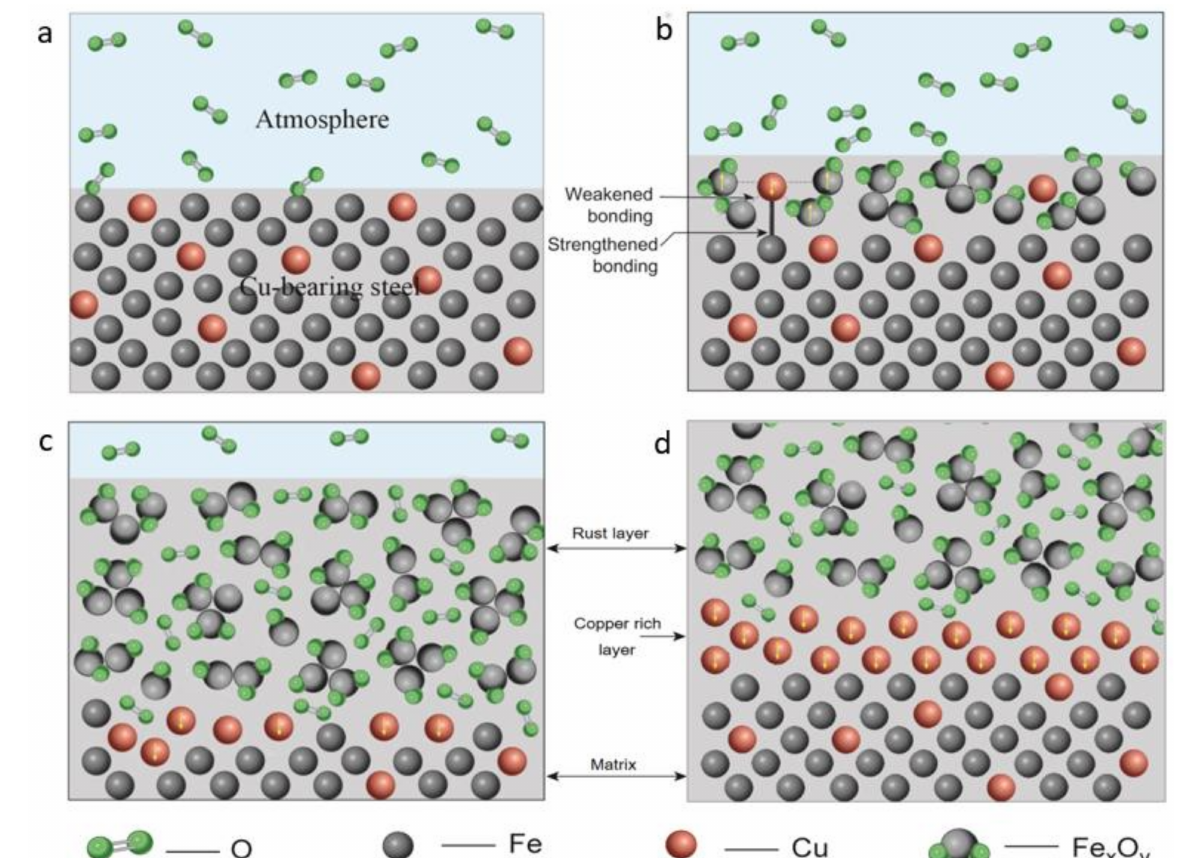
Figure 8. Schematic diagram of copper enrichment mechanism. ( a ) Before corrosion, ( b ) initial stage of corrosion, ( c ) after a short period of corrosion, and ( d ) after a long period of